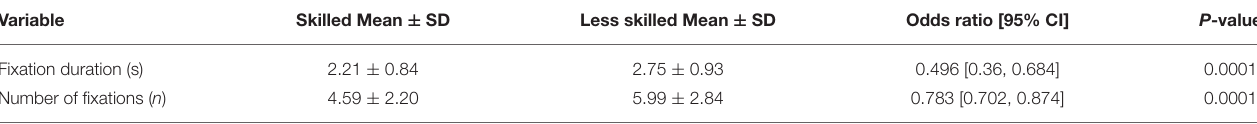
TABLE 2 | Mean visual search characteristics between groups.